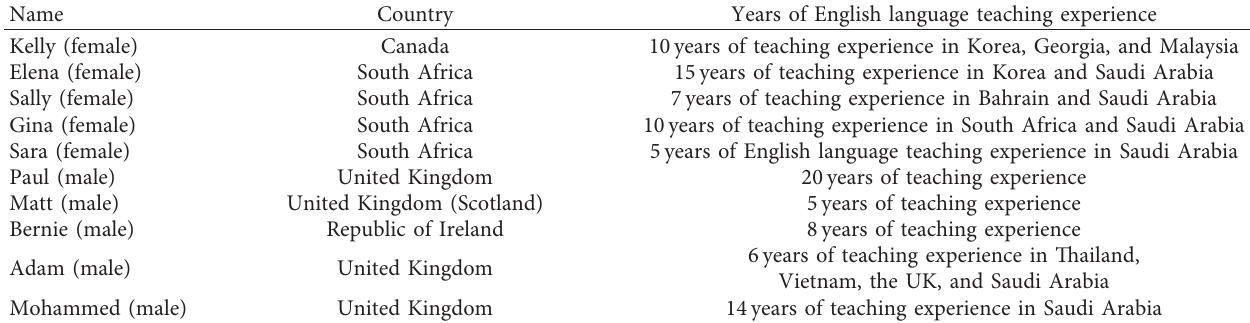
Table 1: Research participants